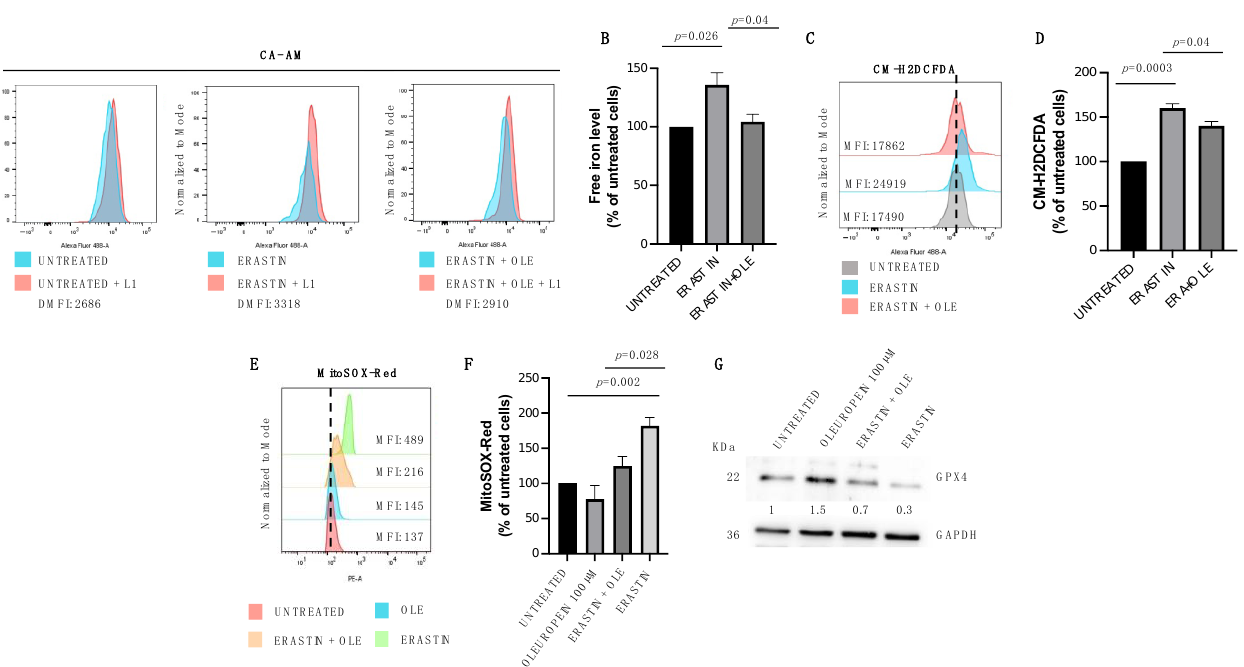
Figure 4. OLE administration mitigates intracellular iron and ROS accumulation induced by erastin. ( A ) Flow cytometry histogram showing LIP levels assessed using Calcein-AM assay in HEY cells untreated, treated with 2.5 µM erastin alone, or in combination with OLE (100 μ M) for 24 h. ( B ) A bar diagram showing LIP levels presented as the % of control (untreated HEY cells). ( C ) Flow cytometry histogram showing the analysis of cytosolic ROS measured upon staining with CM-H2DCFDA in HEY cells untreated, treated with 2.5 µM erastin alone, or in combination with OLE (100 μ M) for 24 h. ( D ) A bar diagram showing ROS levels presented as the % of control (untreated HEY cells). ( E ) Flow cytometry histogram showing the analysis of mitochondrial ROS (mitoROS) quantified by using MitoSOX Red of HEY cells untreated, treated with 2.5 µM erastin alone, or in combination with OLE (100 μ M) for 24 h. ( F ) A bar diagram showing mitoROS levels presented as the % of control (untreated HEY cells). ( G ) Western blot analysis of GPX4 and GAPDH in HEY cells untreated, treated with 2.5 µM erastin alone, OLE (100 μ M) alone, or in combination for 24 h. Densitometric values of GPX4 bands were normalized to GAPDH bands. Values (mean ± SEM; n = 3) are shown. Statistically significant difference was determined by Student’s t- test.